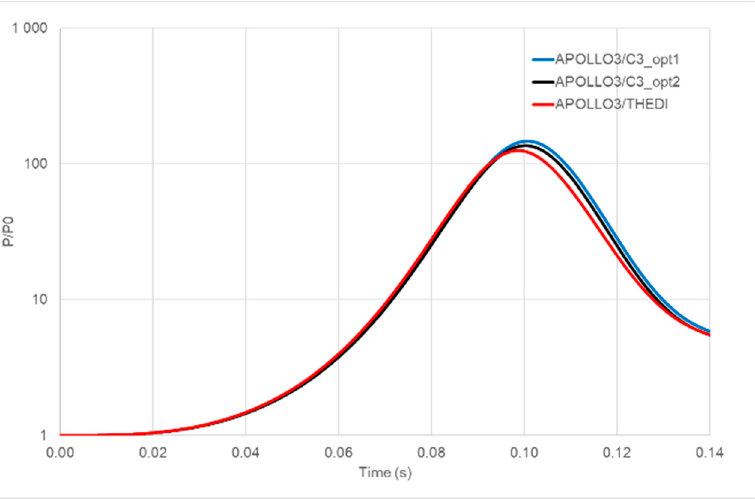
Figure 25. APOLLO3 ® /CATHARE3: preliminary results on power trends.